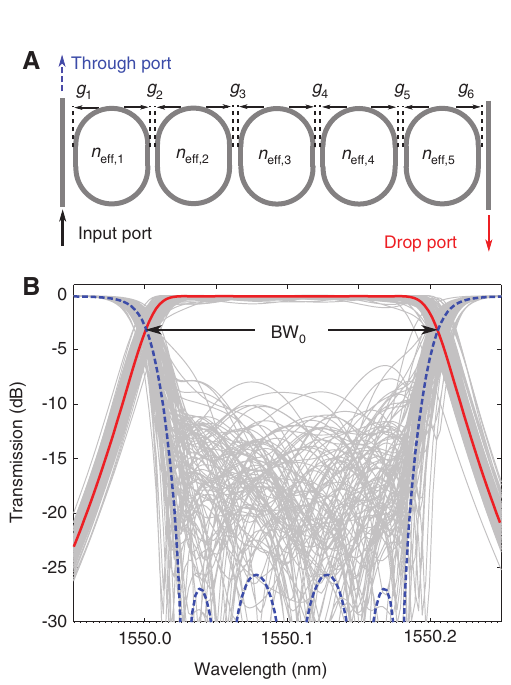
Figure 2: (A) The example circuit is a five-ring coupled resonator filter. (B) Transfer functions of the drop port (red bold solid line) and through port (blue bold dashed line) of the Chebyshev filter nominal design. Gray thin lines plot 100 Monte Carlo simulations of the transfer functions when fabrication variations exist on the effective index of each ring and gap width of each directional coupler. The variations of the effective phase indices and the gaps are assumed to be zero-mean Gaussian distribution with standard deviation = 10 -5 and σ = 5 × 10 -3 μ m, respectively. Figure 1: Proposed robust design optimization σ neff g